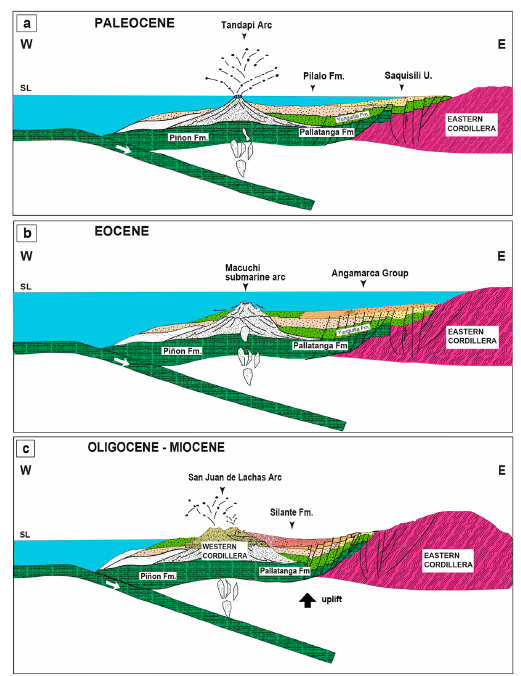
Figure 14. Tectonic evolution of the Western Cordillera of Ecuador during the Cenozoic. The initial uplift started at the end of the Cretaceous. ( a ) Paleocene paleogeography of the Pilalo Formation submarine fan with the coeval Tandapi arc; ( b ) Eocene Macuchi submarine arc and sedimentation of the Angamarca Group; ( c ) during the Oligocene to Middle Miocene there is a rapid uplift of the Eastern and Western Cordilleras, and the deposition of the Silante Formation in an intramontane basin setting. SL: sea